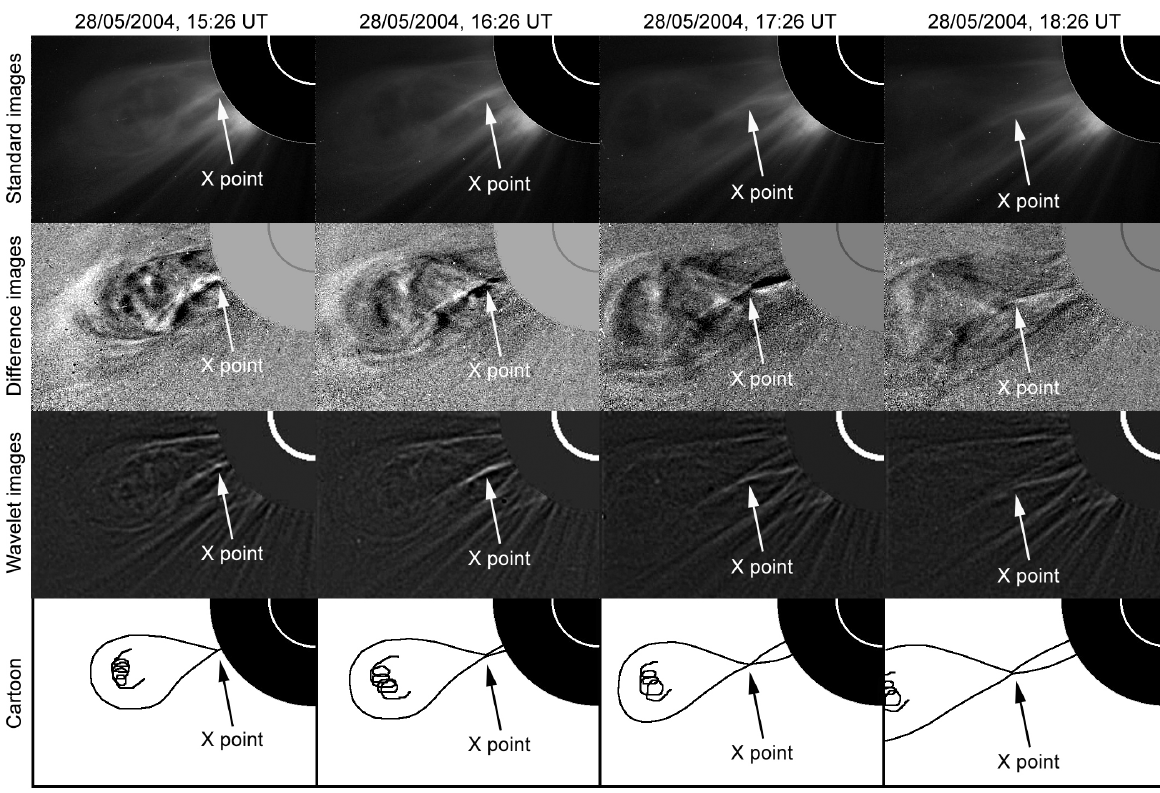
Fig. 4. Top row: LASCO C2 images at four times during the evolution of the CME which occurred on 28 May 2004, at 11:03UT. Middle row, same as top row, for LASCO C2 difference images and, third row, same as above, for LASCO C2 wavelet enhanced images. White arrows, superposed onto the images, point to the position where two approaching features appear to merge. Merging occurs at increasing heliocentric distances with time. The cartoons in the bottom row help visualize the CME scenario identified in LASCO